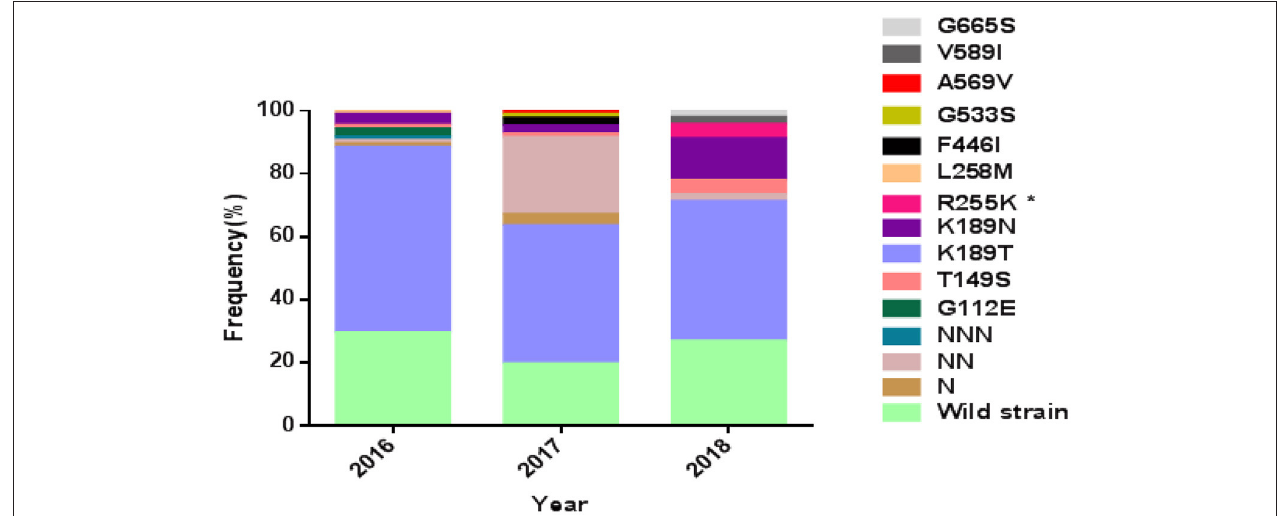
FIGURE 1 | Prevalence of PfK13 mutations from studied isolates. *The difference is statistically significant between 2016 and 2018. TABLE 1 | Prevalence rate of wild and mutant Pfkelch13 gene from studied isolates. Mutants No. (%) of samples No. (%) of samples from No. (%) total p -value from Western Africa Non-Western Africa Wild